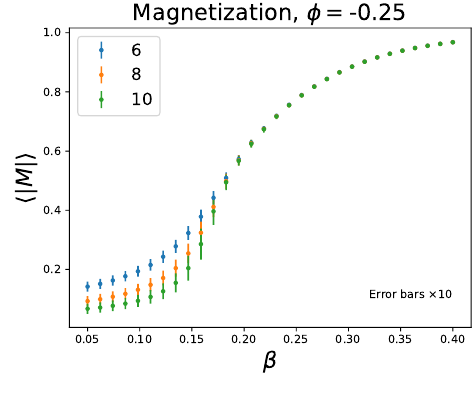
Figure 8: Typical scan of branch point protocol using the cluster algorithm, demon- strating variation of the magnetization for three system sizes; error bars have been scaled upwards by a factor of 10 to make them visible on the